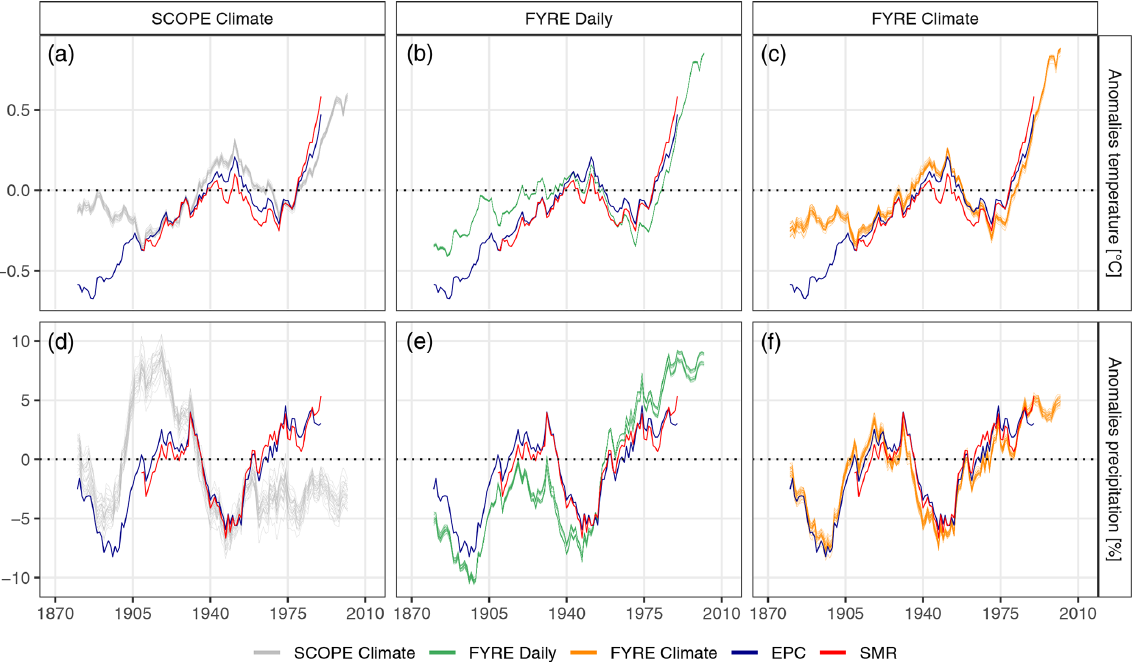
Figure 8. Anomalies of annual temperature (a–c) and precipitation (d–f) averaged over France, and smoothed with a 20-year rolling mean. See text for